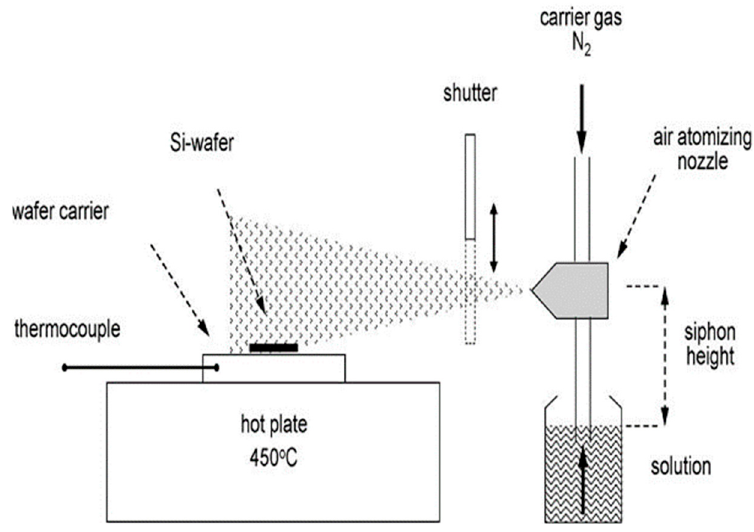
Figure 13. Diagram of spray pyrolysis unit [73].